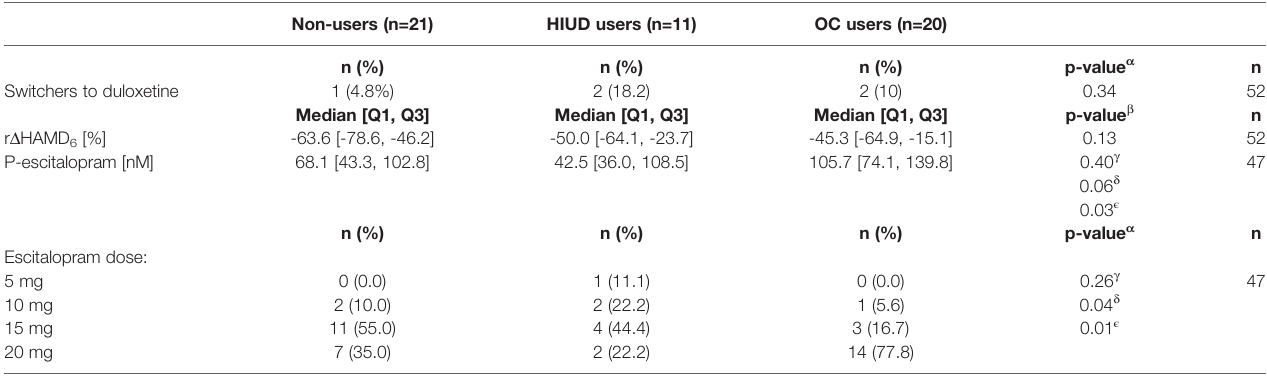
TABLE 2 | Clinical depression pro fi le at week eight.